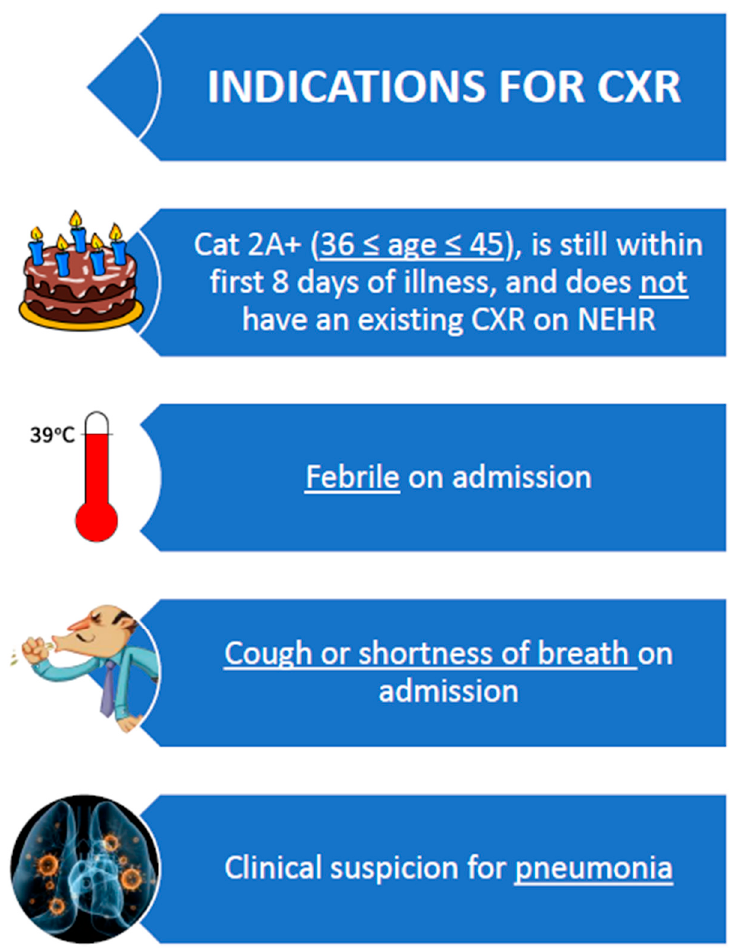
Figure 6. Visual cue charts at consultation stations: indications for chest radiograph.